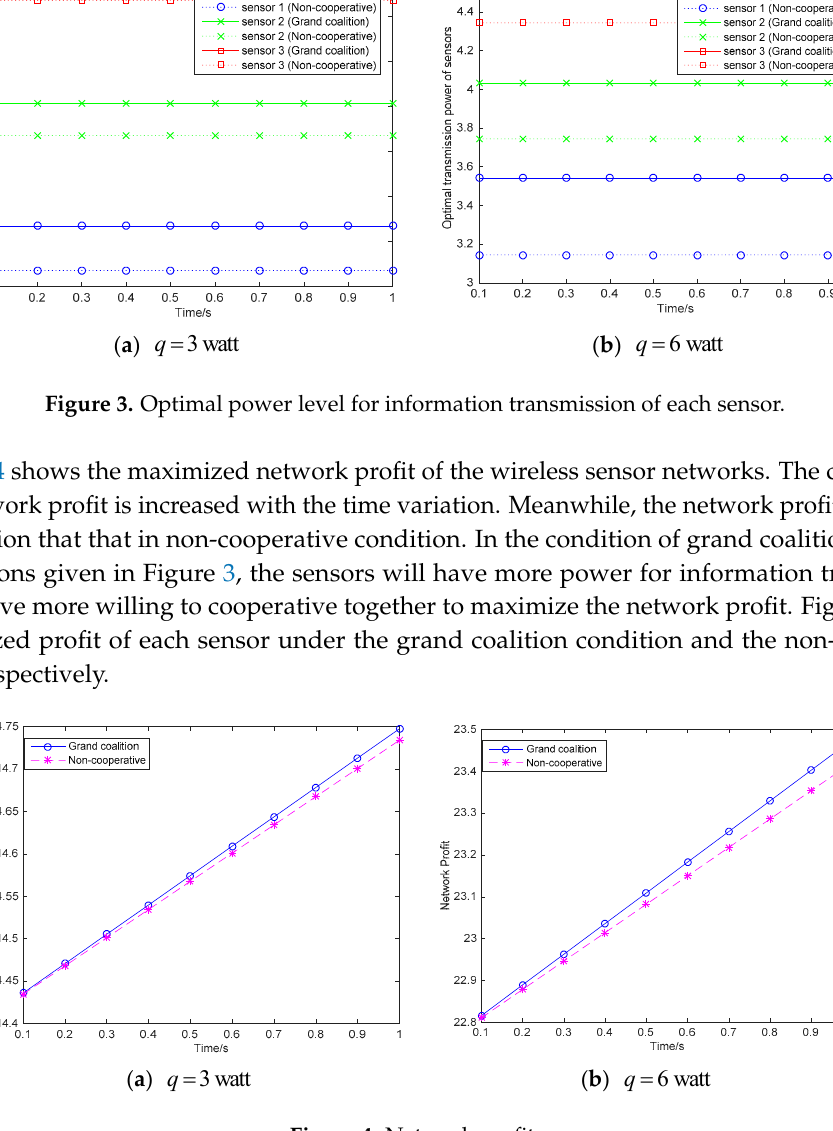
Figure 4. Network profit.